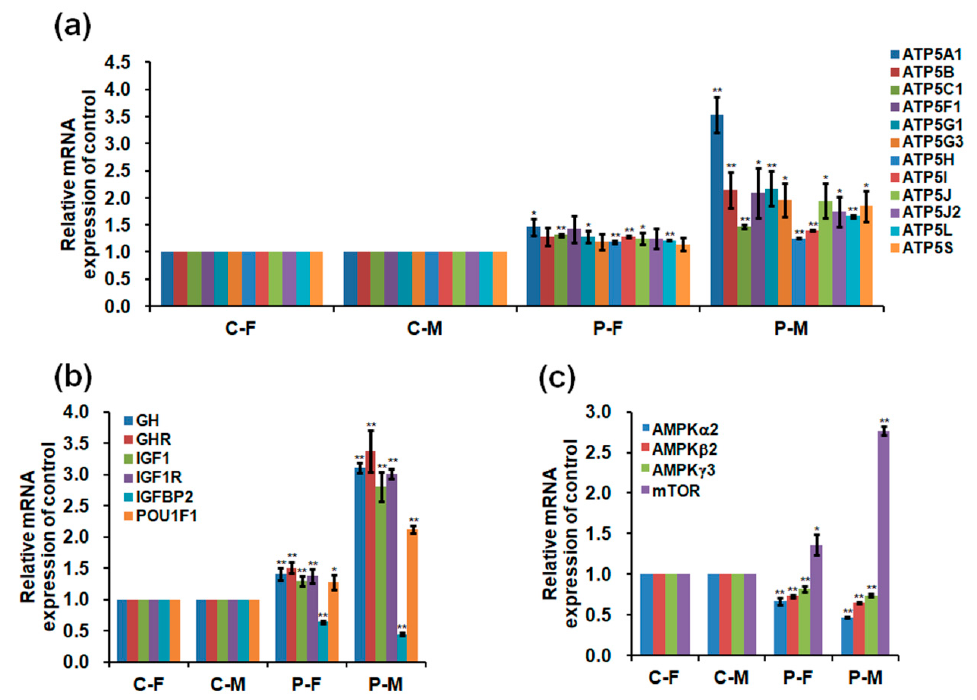
Figure 5. Ultrastructure of skeletal muscles and mitochondrial respiratory enzyme levels in 90-day- old male chickens. ( a ) Representative longitudinal section of skeletal muscles. Z line, M band, and sarcomere in the myofibril are clearly observed. Mitochondria located between myofibrils are photographed using a transmission electron microscopy. The arrow shows the mitochondrion. Scale bar: 2.0 μ m. ( b ) Nicotinamide adenine dinucleotide hydrogen (NADH) levels in the mitochondria of skeletal muscles. Activities of mitochondrial respiratory enzyme ( c ) cytochrome c oxidase and ( d ) ATPase synthase in skeletal muscles. Data are presented as mean ± SD ( n = 10) of three replicates; n represents an individual chicken. **, p < 0.01 versus control, according to the one-way ANOVA with an LSD test.